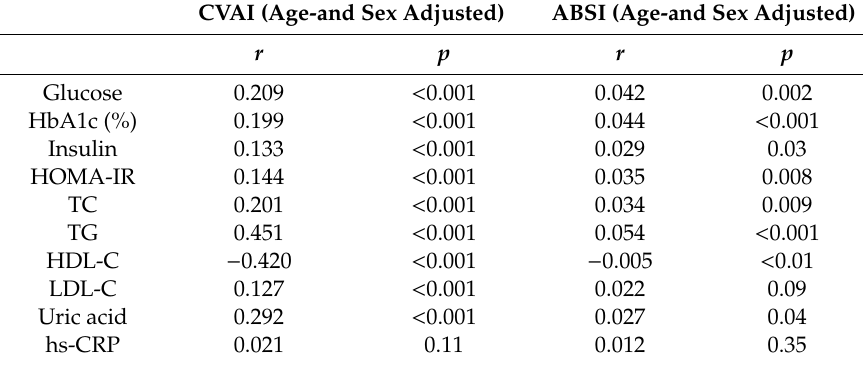
Table 3. Correlations of CVAI and ABSI with metabolic variables among adults in China. CVAI (Age-and Sex Adjusted) ABSI (Age-and Sex Adjusted)